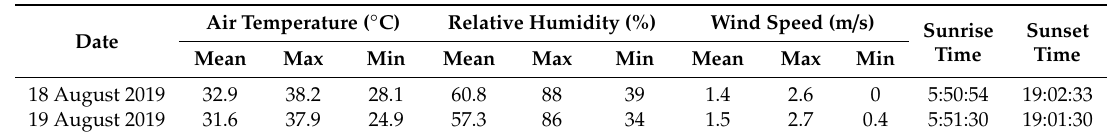
Table 3. General meteorological conditions on the micrometeorological measurement days and sunrise and sunset times in Wuhan, the China 1 .